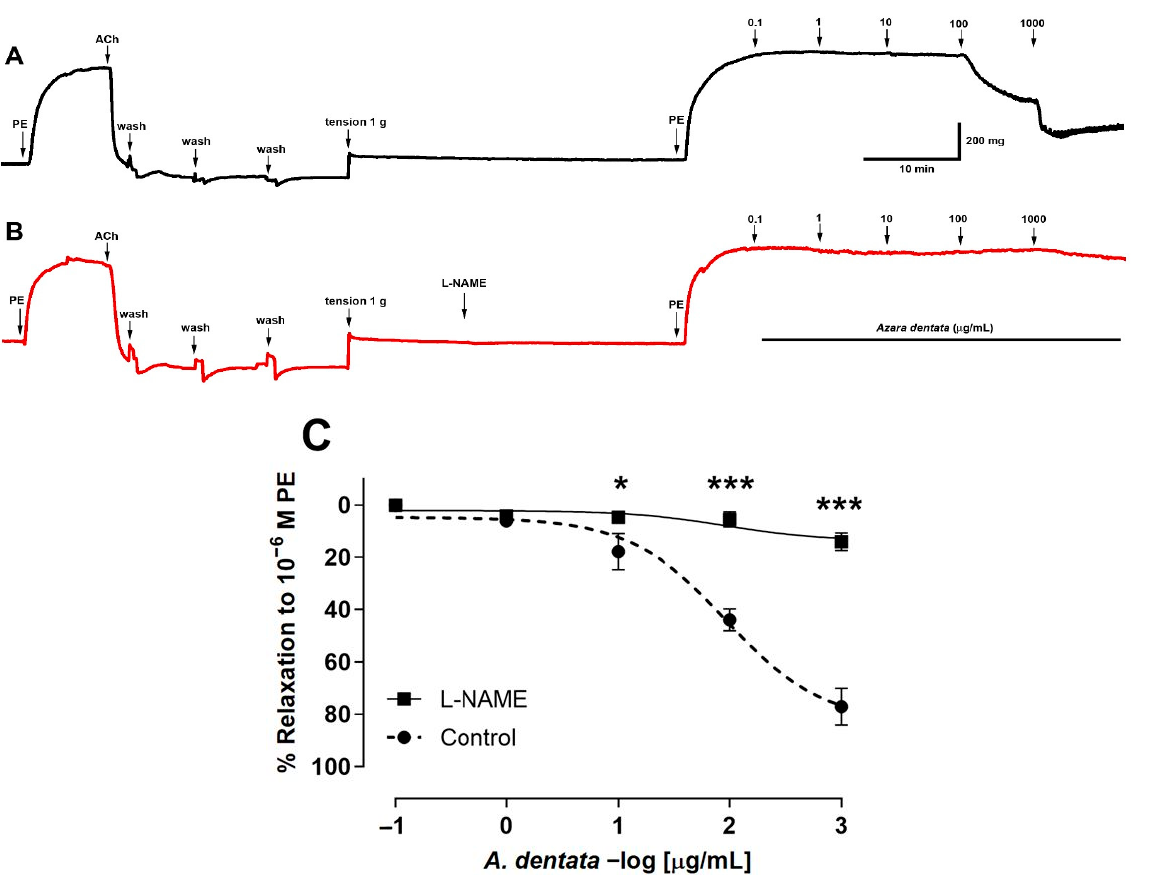
Figure 5. Original record of the vascular response to A. Dentata extract in intact rat aorta (A,B). Previously, vascular endothelium was tested with 10 − 5 M acetylcholine in pre ‐ contracted aortic rings with 10 − 6 M phenylephrine (PE). Effect of the extract on the aortic ring in absence of L ‐ NAME (black line) ( A ) versus aortic ring pre ‐ incubated with 10 − 4 M L ‐ NAME for 20 min (red line) ( B ). Aortic rings pre ‐ incubated with 10 − 4 M L ‐ NAME or absence (Control) ( C ). Rat aorta was pre ‐ contracted with 10 − 6 M phenylephrine (PE) for 10 min, and then, rising concentrations of A. dentata (0.1 to 1000 μ g/mL) were added in organ bath at 7 min intervals. Data are presented as the average standard error of the mean (SEM) of 5–7 independent experiments. * p < 0.05, *** p < 0.001.